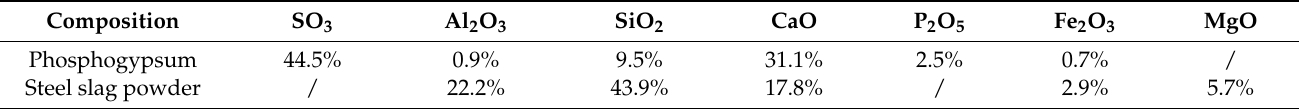
Table 2. Mechanical properties of asphalt.